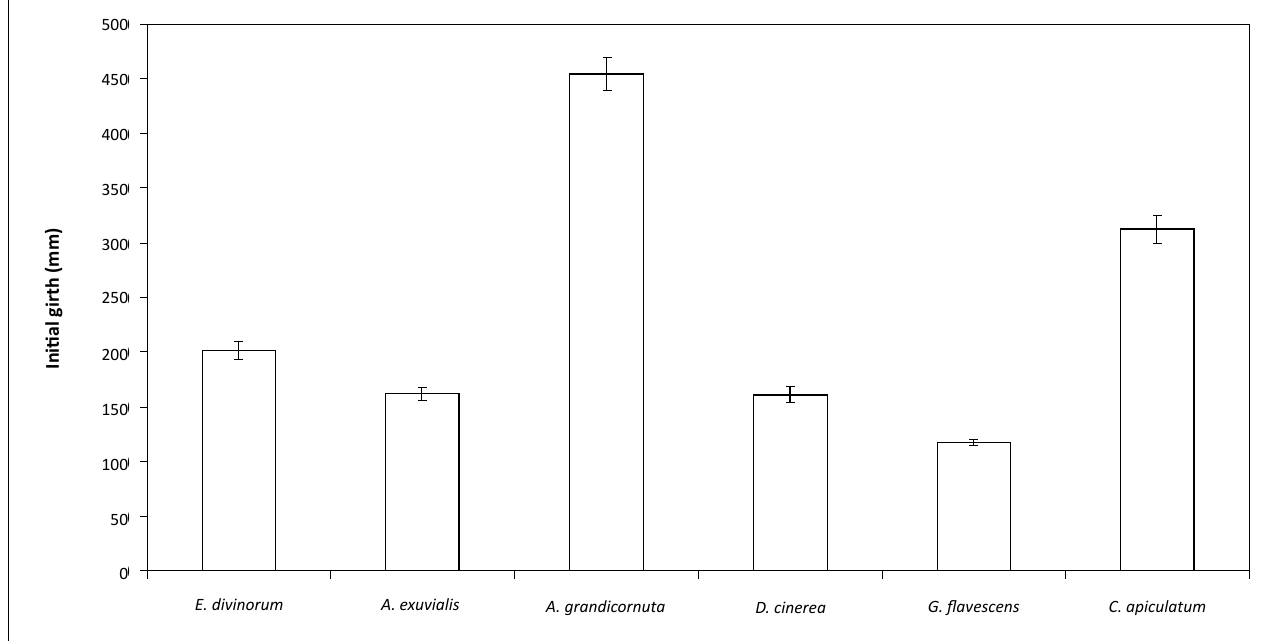
FIGURE 2: Mean initial girth (mm) of stems fitted with dendrometers at the Nkuhlu exclusion experiment. Error bars are standard errors of the means (from left to right, n = 39, 41, 41, 39, 39 and 44). Species from left to right are: Euclea divinorum , Acacia exuvialis , Acacia grandicornuta , Dichrostachys cinerea , Grewia flavescens and Combretum apiculatum